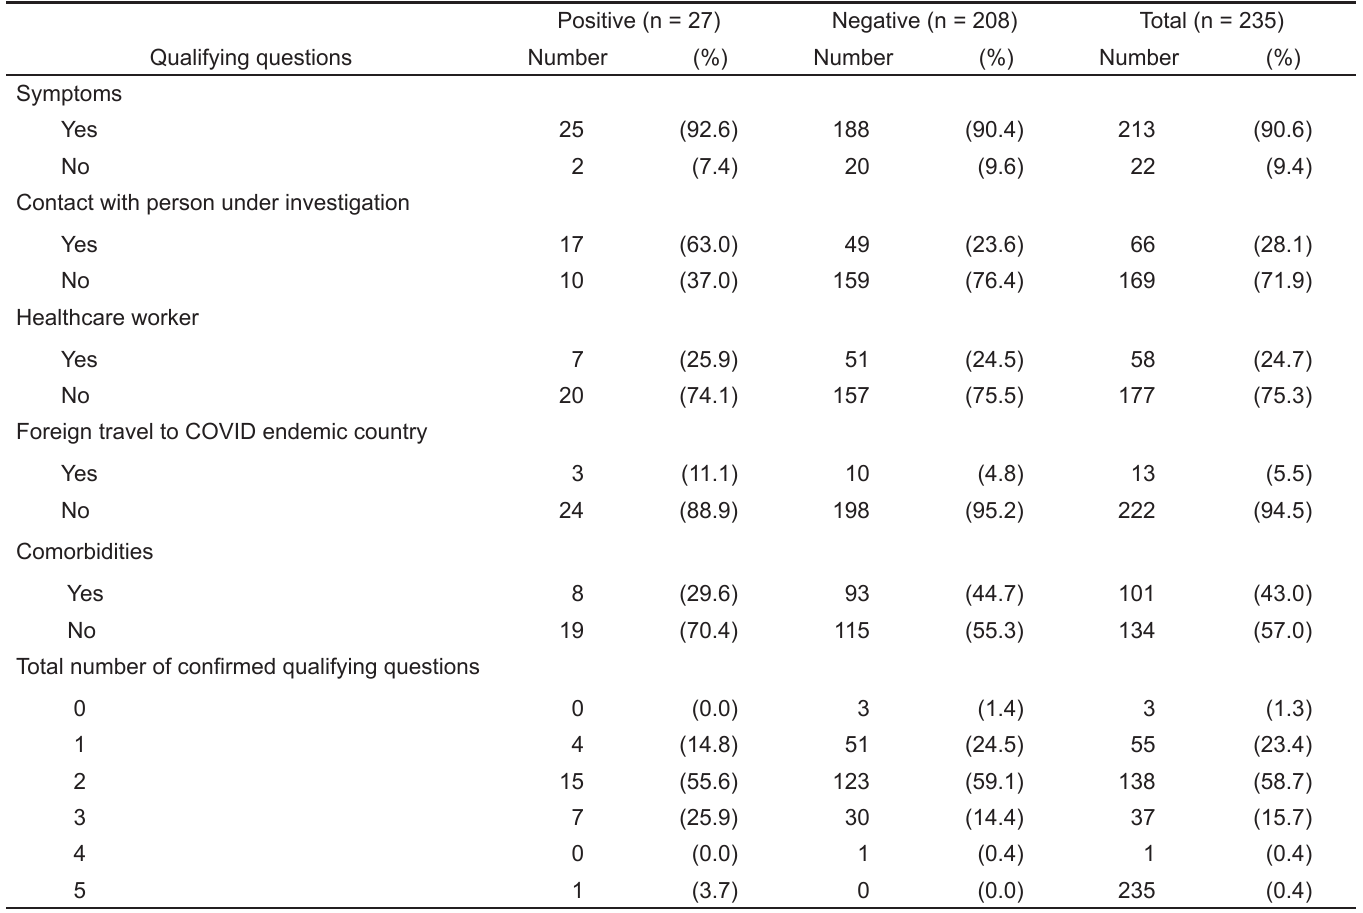
Table 2. COVID-19 test qualifying question for patients who were tested for COVID-19 during the first 10 days of testing (n = 235/283